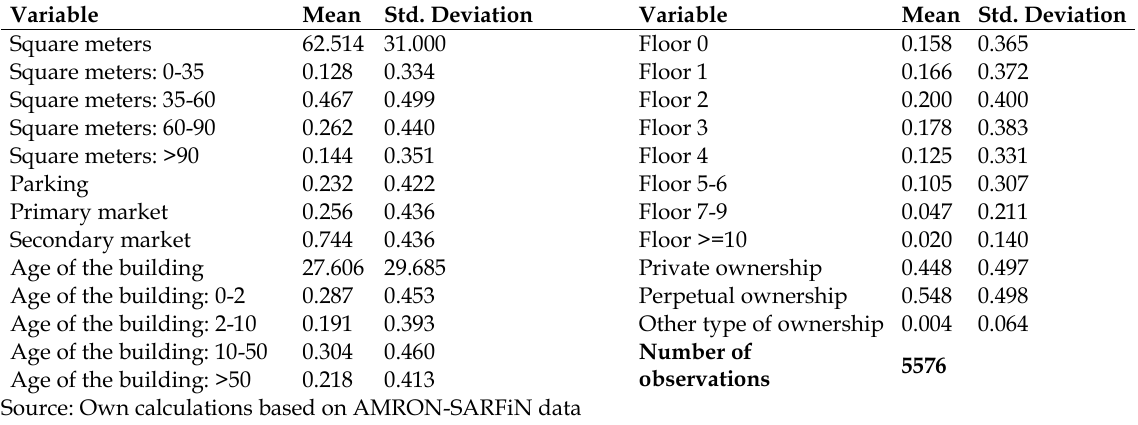
Summary statistics of physical characteristics of properties